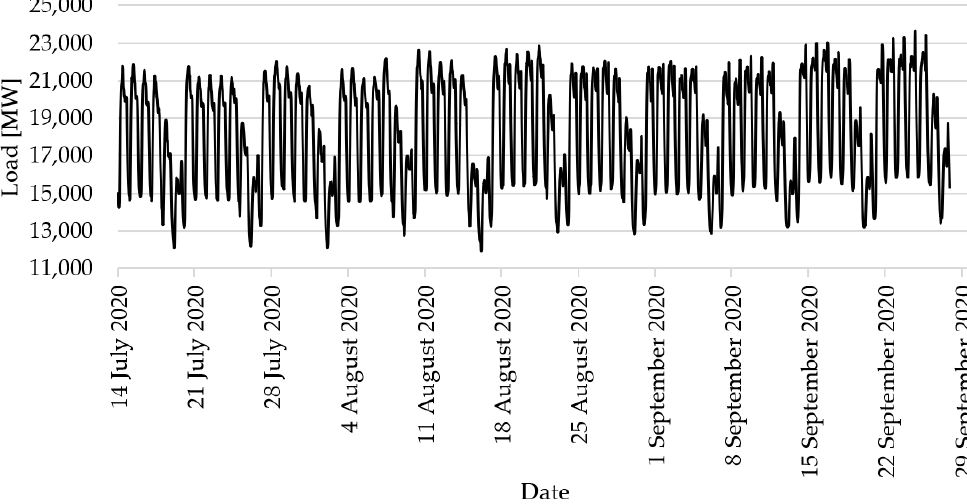
Figure 8. Noise-disturbed load time series.